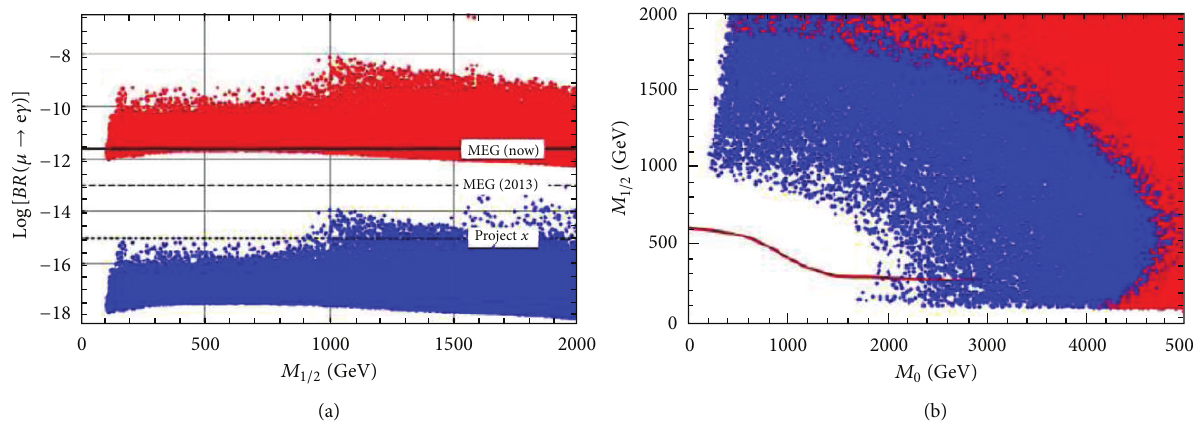
= 0.11 [80]. The e 3